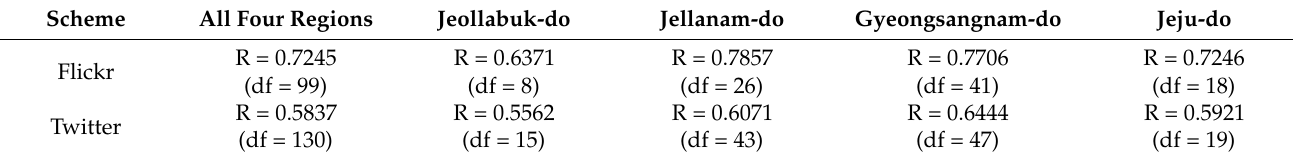
Table 2. Pearson correlation coefficient between social media data and visitation data ( p < 0.05). Scheme All Four